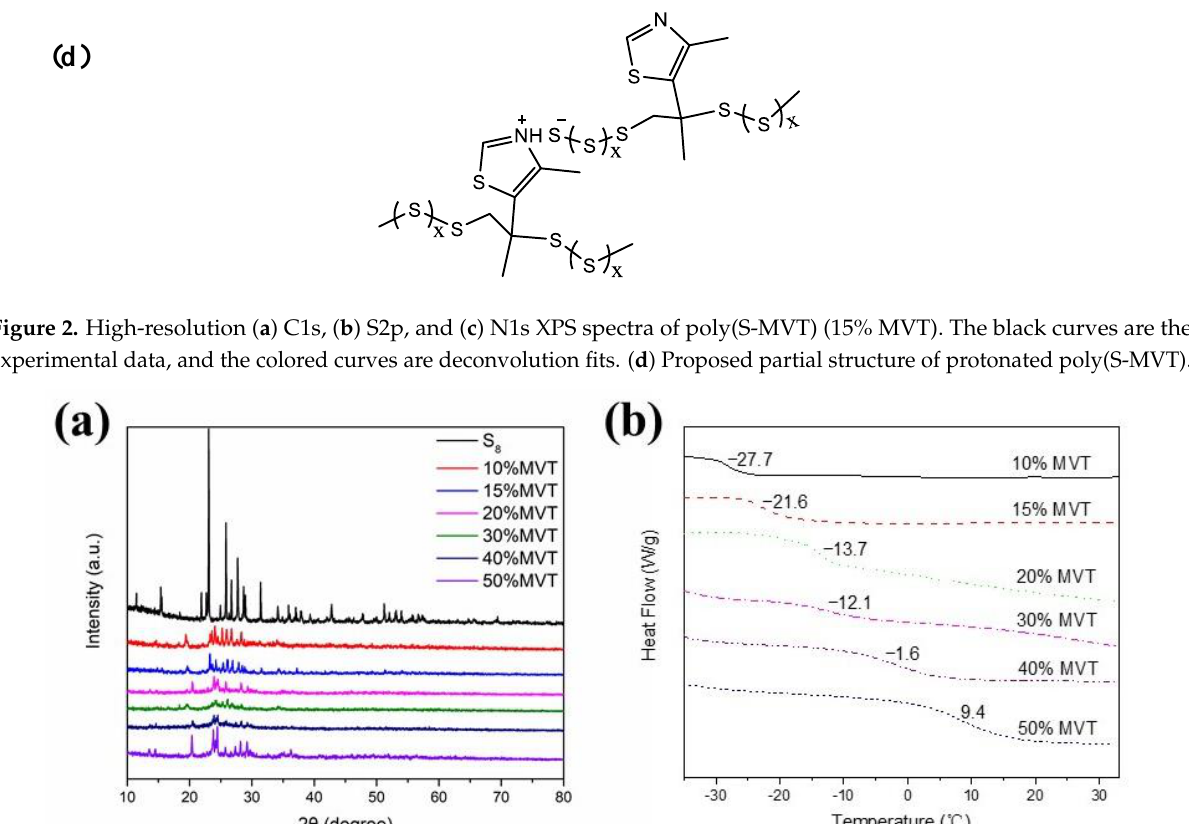
Figure 3. ( a ) XRD patterns of poly(S-MVT)s with different MVT content. ( b ) DSC thermograms of poly(S-MVT)s (second